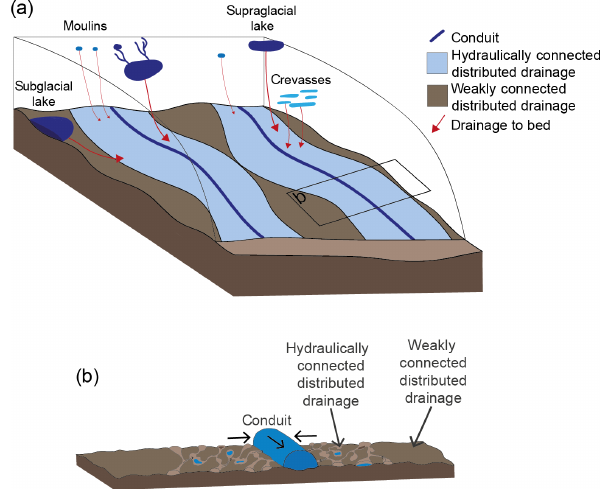
Figure 1. (a) Ice sheet hydrological system with varying surface and basal inputs and (b) a three-system drainage model. In the three- system drainage model, the hydraulically connected distributed drainage system (light blue in a ) is influenced regularly by surface meltwater inputs through the conduit. The weakly connected dis- tributed drainage system (dark brown) is largely isolated and rarely or never impacted by surface meltwater inputs. At present, the rela- tive coverage of each is not yet known, nor is the precise configura- tion or relation between each